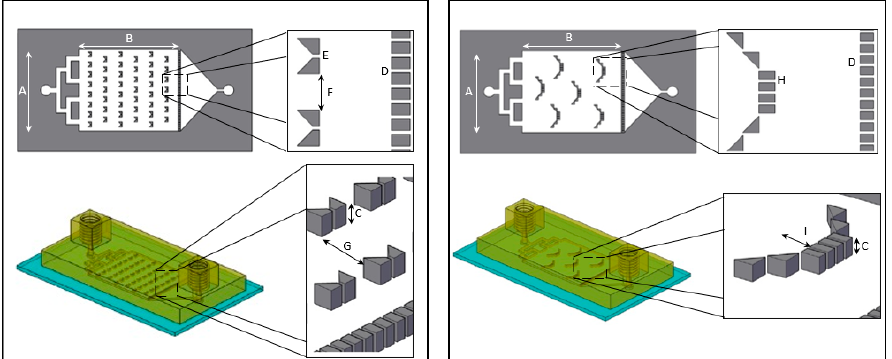
Figure 1. Overhead and side view schematic illustration of “V” (left) and “basket” (right) shape dissolution microfluidic chip. The overall dimensions of the “V” and “basket” shape chips are identical with a main chamber width ( A ) of 16 mm, length ( B ) of 20 mm and height ( C ) of 600 µ m. Both chips contain a downstream trap of 38 teeth separated by 120 µ m gaps ( D ). “V” trap design (left): includes two trapezoids separated by 120 µ m gap ( E ). The V traps are lined in six rows of on and off seven and eight traps, with a 1 mm gap between traps ( F ) and separated by 2.4 mm gap ( G ). “Basket” trap design (right): includes four rectangular teeth and additional two diagonal triangular teeth placed on both sides, separated by 120 µ m gaps ( H ) creating a 1.2 mm depth ( I ).